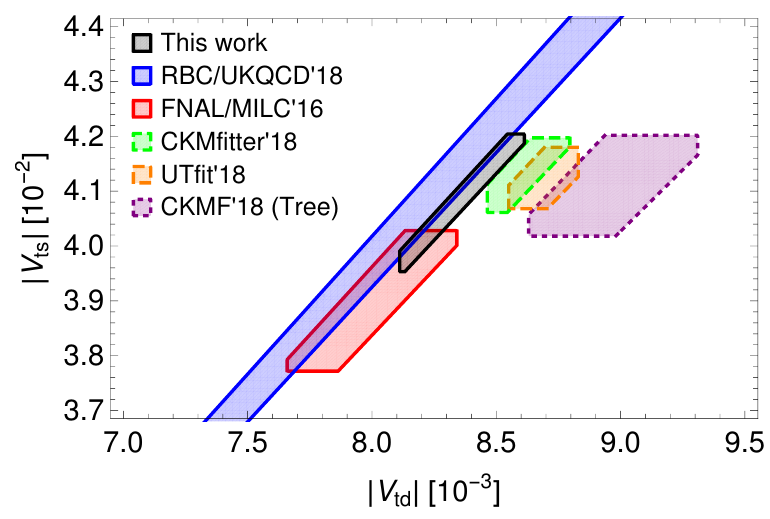
Figure 7 . Comparison of our constraints on the CKM parameters j V td j and j V ts j with other works based on B mixing [12, 17] (solid boundaries) and unitarity [49, 59] (dashed boundaries). Since the full CKM (cid:12)t includes the mass di(cid:11)erences we also show the tree-level (cid:12)t from CKM(cid:12)tter [49] (dotted